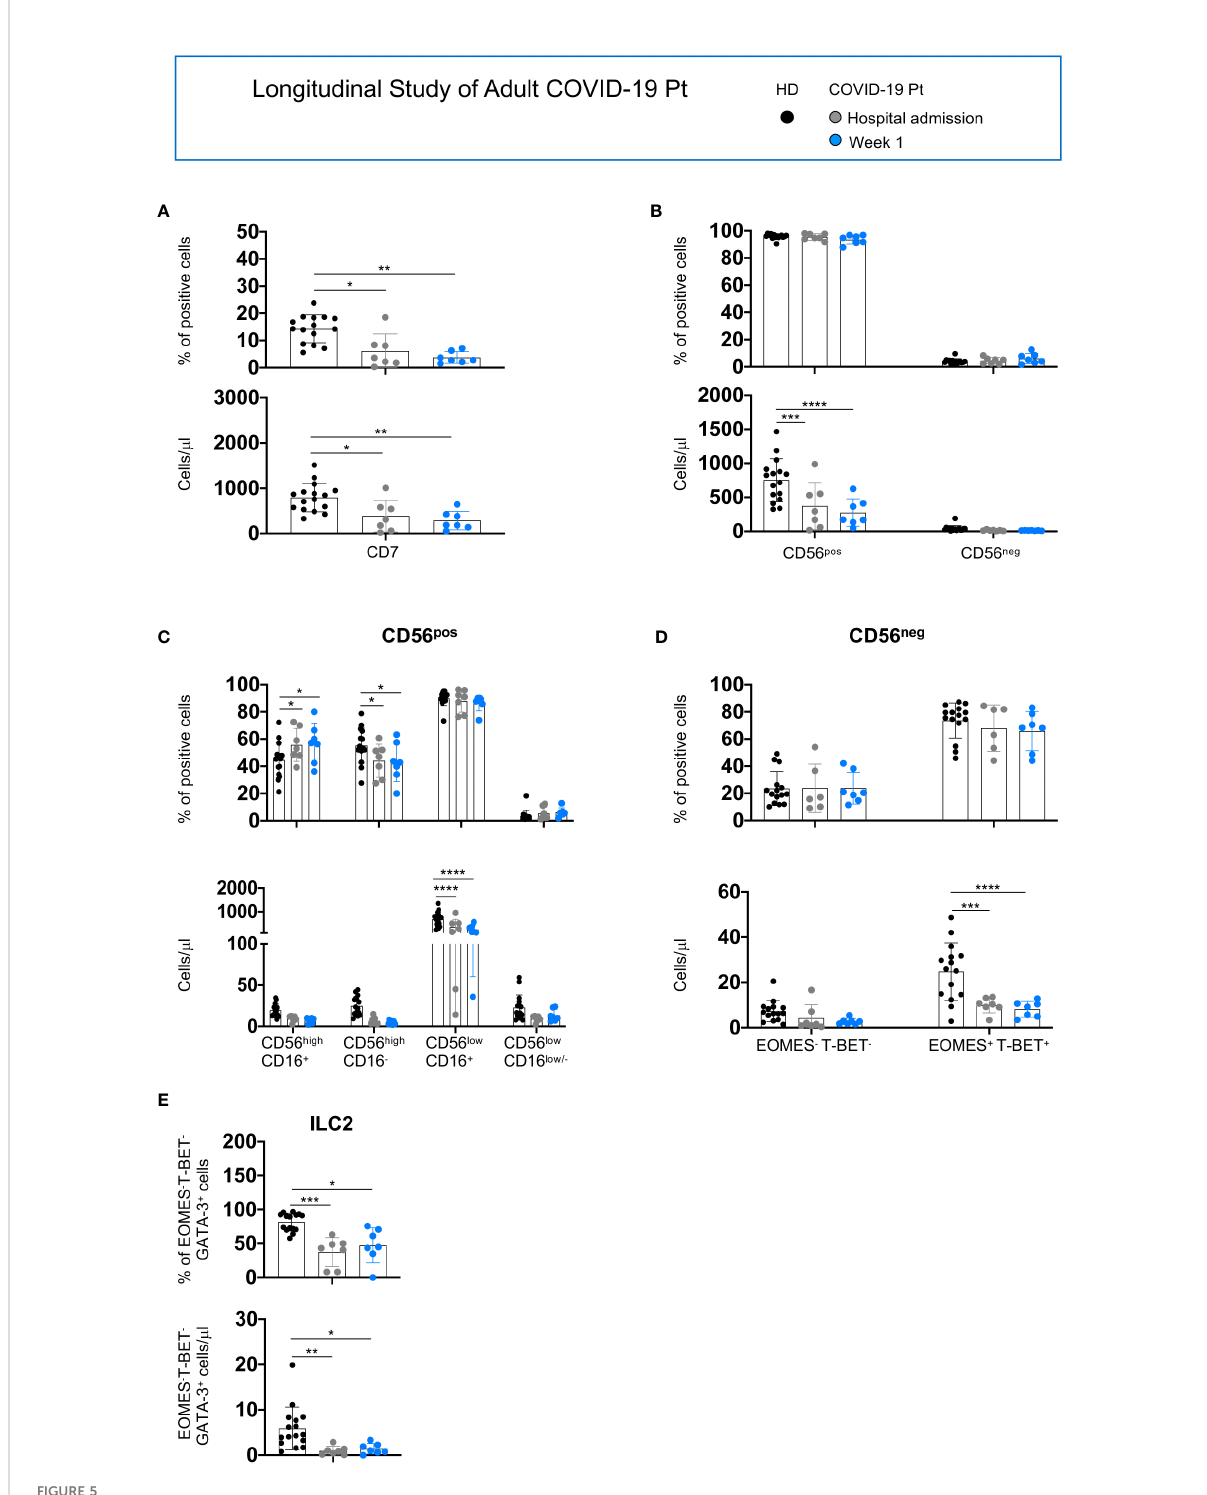
FIGURE 5 Longitudinal analysis of NK/ILC populations in adult COVID-19 patients. Histograms represent the mean ± SD of the frequency and the absolute count of CD7 + (A) , CD56 pos and CD56 neg (B) , CD56 high (C) and CD56 low (D) and ILC2 (E) in adult patients (n = 7) at 1week post-hospitalization. Cell populations were gated as described above. * p< 0.05, ** p< 0.01, *** p< 0.001, **** p< 0.0001. Two-way analysis of variance (ANOVA) Tukey ’ s multiple comparisons test and One way ANOVA Kruskal-Wallies test multiple